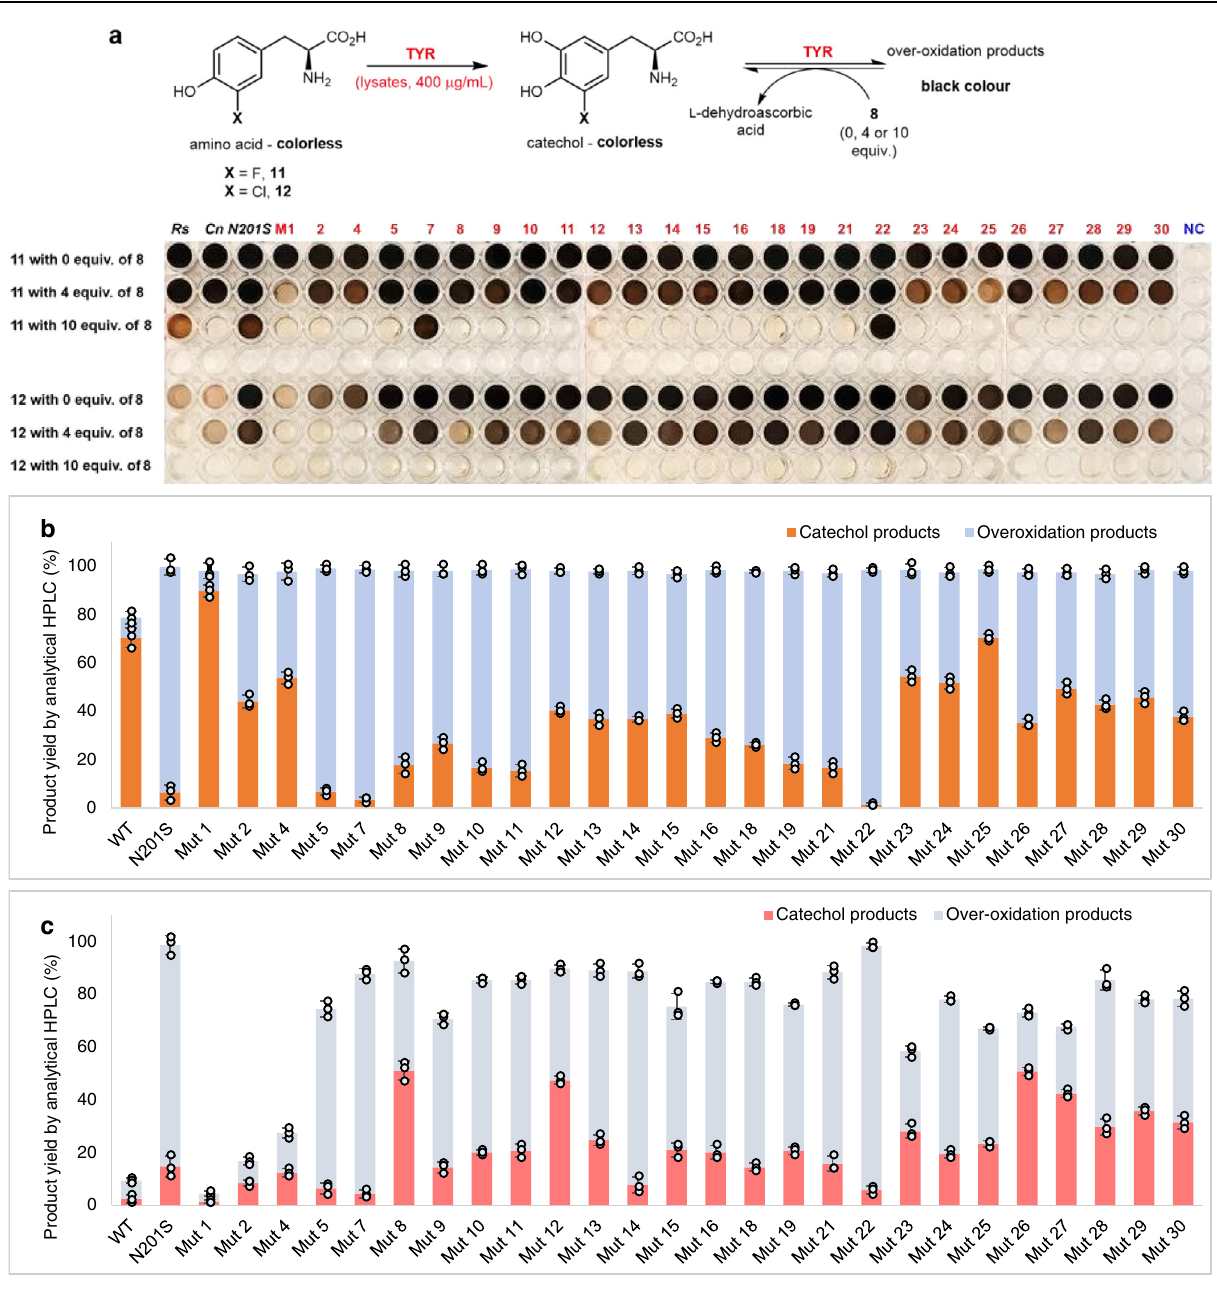
Fig. 5 | Directedevolution basedonCnTYR-N201Sand enzyme screening data. a Enzyme screening for the random mutagenized variants based on Cn TYR-N201S with3-F-L-tyrosine 11 and3-Cl-L-tyrosine 12 . Reactionconditions : 11 and 12 (2.5mM, 1 equiv.),enzyme lysates (400 μ gmL − 1 ) andCuSO 4 (5 μ M)with 0,4 equivalents and 10 equivalents of sodium ascorbate 8 , respectively. Reactions were performed at 25°C for 8h. The black colour indicates the diphenolase activities of the tyr- osinases. Note: WT- Rs TYR ( Rs ) 19 , Cn TYR ( Cn ), and Cn TYR-N201S (N201S) lysates were used as positive controls and cell lysates of an empty plasmid as a negative control (NC). b Productyieldsand componentsofTYR reactions with 4 equiv. of 8